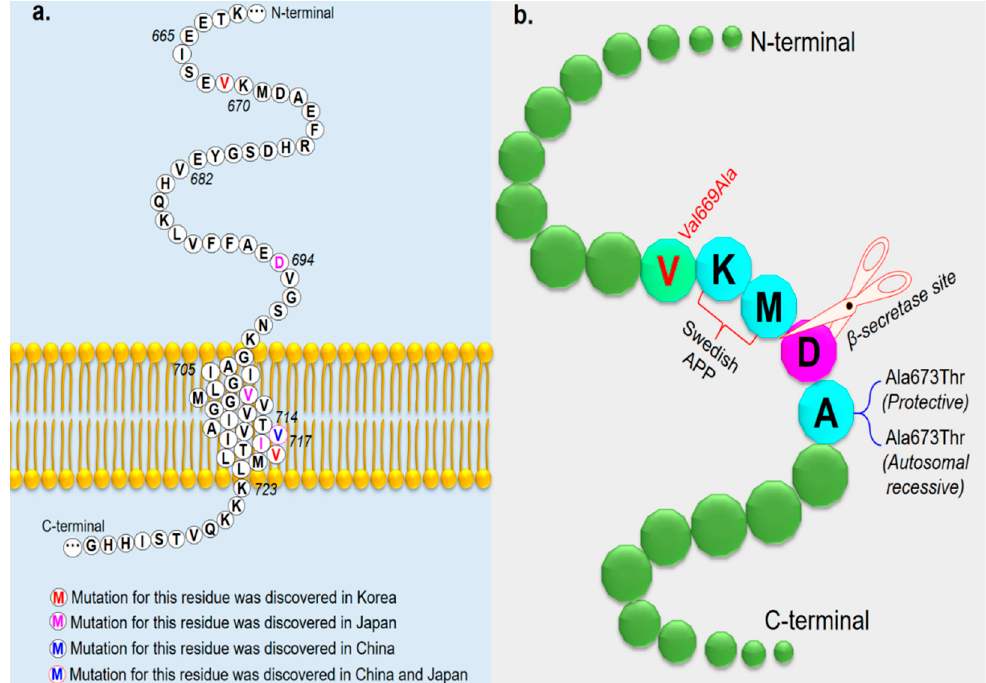
Figure 2. ( a ) Mutated APP residues identified in Asian countries are shown in different colors. ( b ) Location of Val669Leu in APP and mutations located near the β -secretase cleavage site. The nearest mutation is the “Swedish APP” mutation. Additional mutations located near the β -secretase cleavage site are the protective Ala673Thr and the pathogenic Ala673Val.